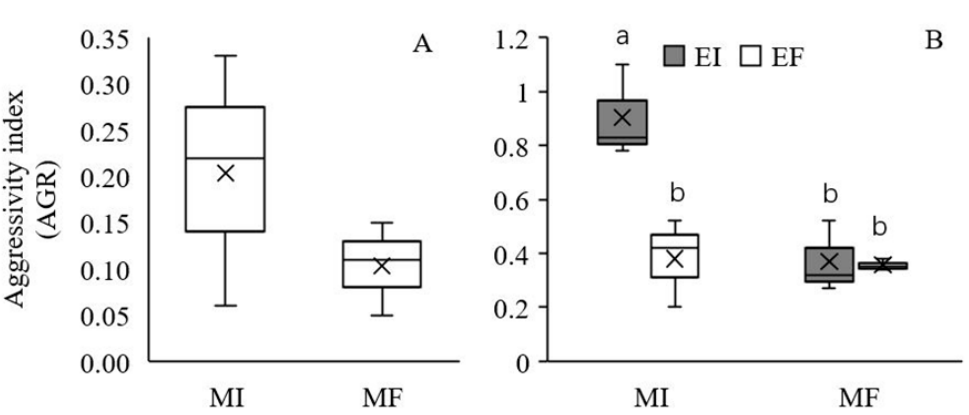
Figure 4. Effect of soil microbes on the aggressivity index (AGR) of Leymus chinensis in intraspecific competition ( A ) and effect of the interaction between Epichloë endophyte colonization and soil microbes on the AGR of L. chinensis in interspecific competition ( B ). The different letters above bars denote means that are significantly different among treatments ( p < 0.05). EI, Epichloë endophyte-colonized L. chinensis ; EF, endophyte-free L. chinensis ; MI, soil microbe inclusive; MF, soil microbe free. Symbol ‘×’, horizontal line in the box, top and bottom of box edges and bars indicate the average value, median, 25% and 75% quartiles, and 5% and 95% quantiles, respectively. The RII provides a simple comparison of interaction strength across species and treatments. Under intraspecific competition, the RII values of both EI and EF L. chinensis were negative in both the MI and MF treatments, and only the RII of EI L. chinensis was less negative compared to that of EF L. chinensis (Table 2, Figure 5A,B). The results indicate that EI and EF L. chinensis suppressed each other, but the magnitude of the negative effect of EI on EF L. chinensis was larger. The presence of soil microbes did not have a significant effect on the RII of L. chinensis (Table 2, Figure 5B) . In terms of the response of L. chinensis to competition with S. krylovii , the presence of S. krylovii facilitated the growth of EI L. chinensis (RII > 0) but had no influence on EF L. chinensis , and a significant main effect of Epichlo ë endophytes was observed (Table 2, Figure 5C). In addition, the presence of soil microbes significantly enhanced the promoting effect of S. krylovii on L. chinensis under interspecific competition (Table 2, Figure 5D). However, no significant interactive effect between Epichlo ë endophytes and soil microbes was observed (Table 2). The RII of S. krylovii was significantly affected by Epichlo ë endophyte colonization, soil microbes and their interaction (Table 2). Furthermore, L. chinensis had a negative effect on S. krylovii (RII < 0). Epichlo ë endophyte colonization had no significant effect on the RII in the MF treatment, but a stronger negative effect of EI L. chinensis on S. krylovii was observed in the MI treatment (Figure 5E).